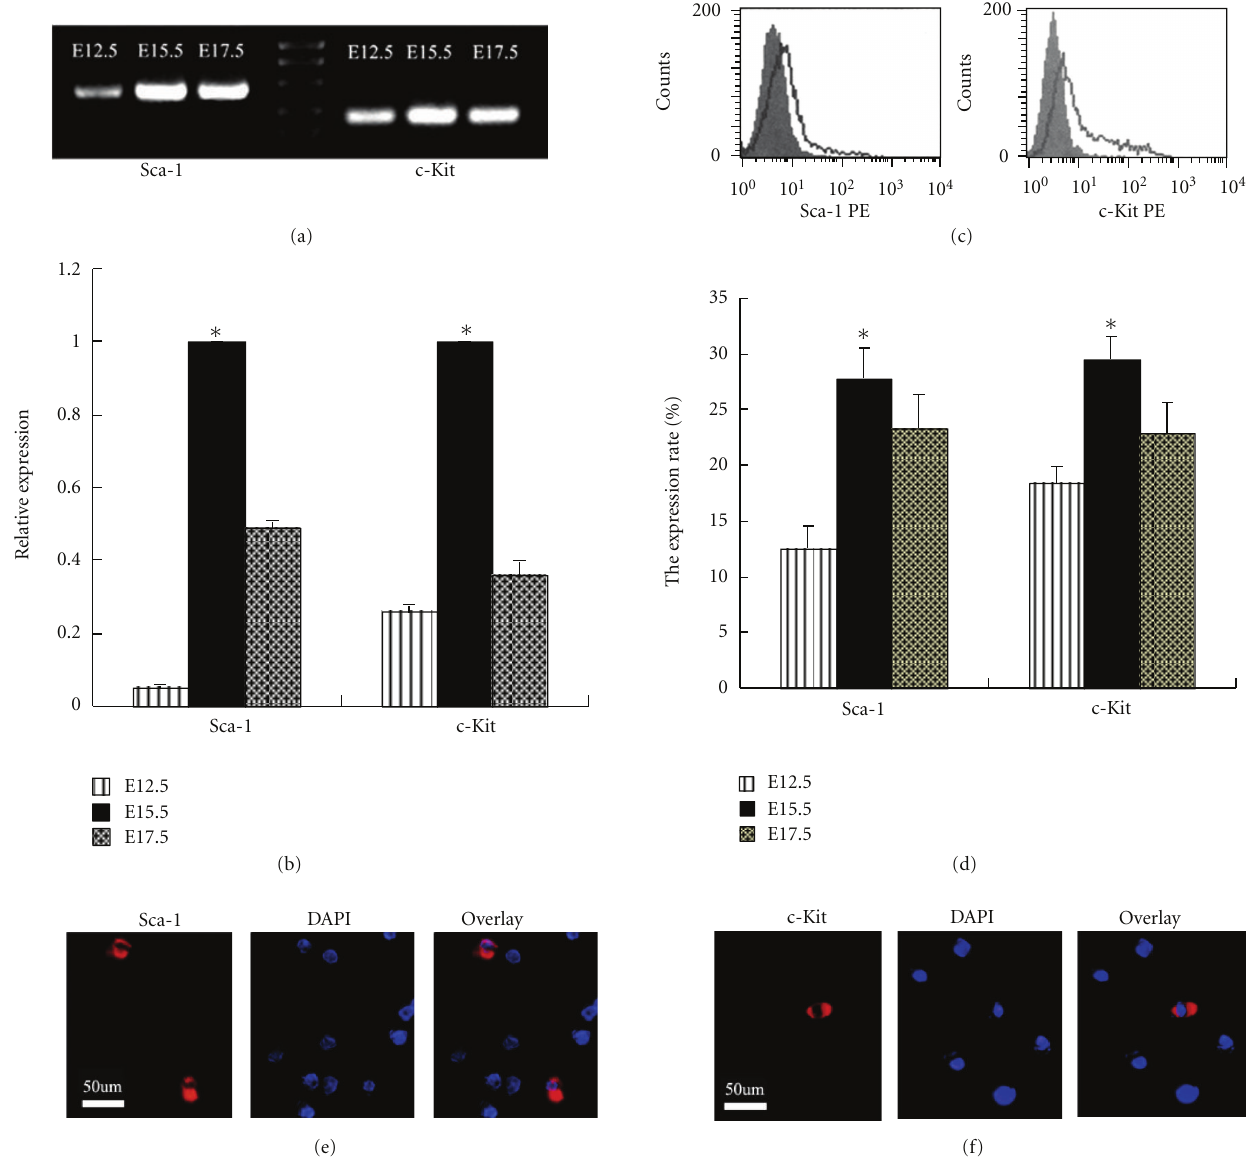
Figure 1: The expression of Sca-1 and c-Kit in embryonic pancreas. Representative picture of agarose gel electrophoresis (a). The quantitive analysis of Sca-1 and c-Kit mRNA expression by real-time PCR (b). Representative flow cytometric results of Sca-1 and c-Kit expression at E15.5 (c). The quantitive analysis of Sca-1 and c-Kit protein expression (d). Immunofluorescent analysis of Sca-1 and c-Kit localization (e, f). ∗ P < 0 . 05 versus E12.5 and